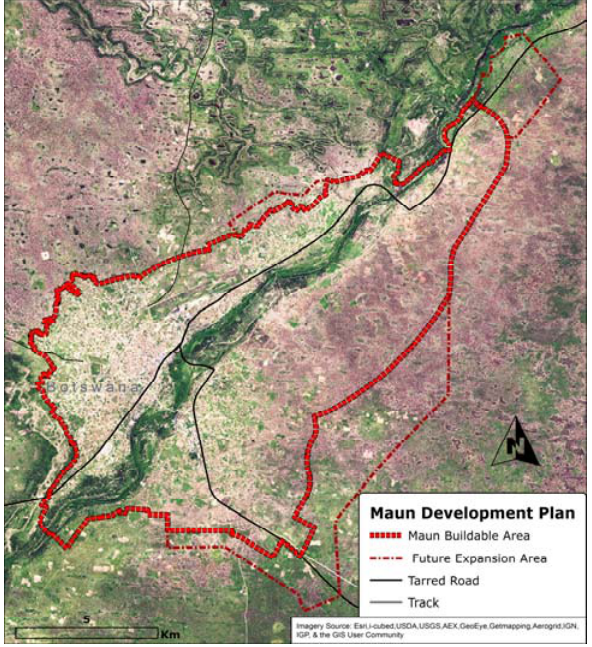
Figure 3. Boundaries and extent of Maun Development